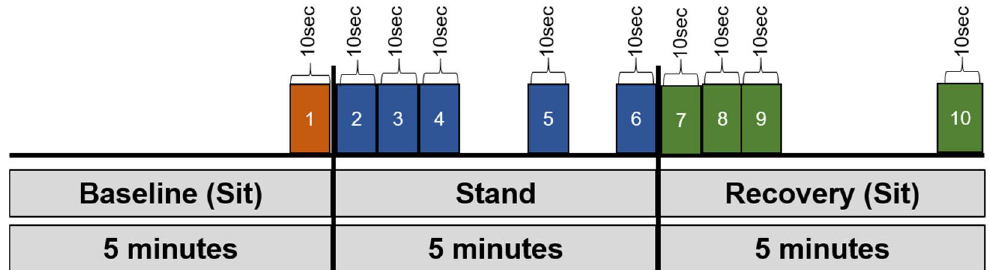
Figure 2. Overview of the epochs that we defined and used for data analysis. Several key epochs were examined (191): (1) final 10 s of sitting baseline, (2) 0–10 s, (3) 10–20 s, (4) 20–30 s, (5) 290–300 s, and (6) final 10 s of stand phase, as well as (7) initial 0–10 s, (8) 10–20 s, (9) 20–30 s, and (10) final 10 s of sitting recovery.